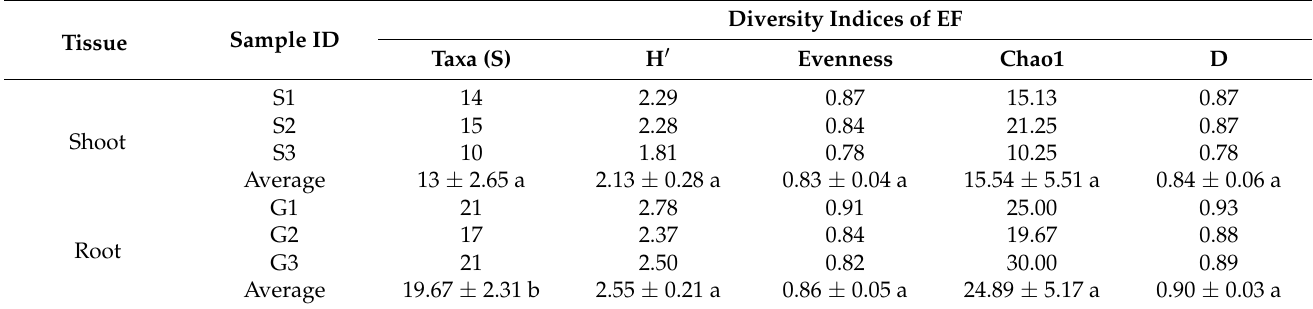
Table 3. Alpha diversity indices of culture-dependent endophytic fungi (EF) in tissues of S. chamaejasme